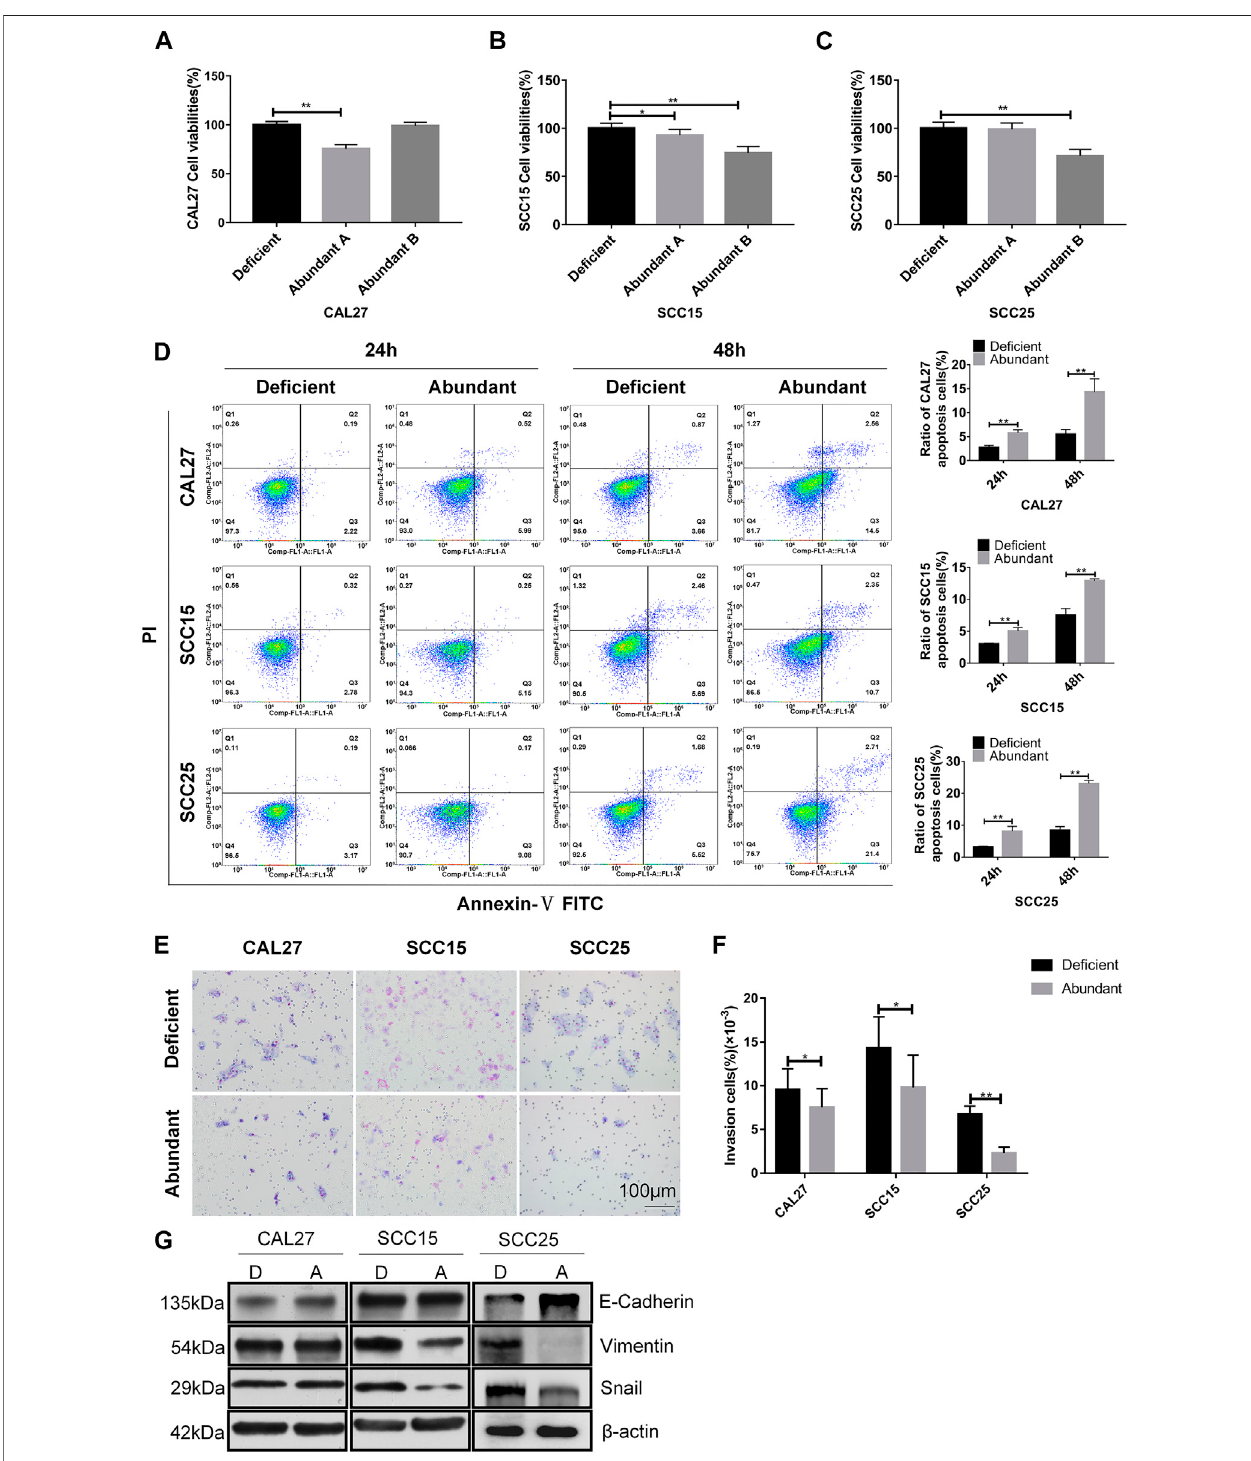
FIGURE2 | Effectsofanti-HER2IgG-abundantplasmaontheproliferationofOSCCcells. (A – C) ProliferationofthreeOSCCcelllinestreatedwithanti-HER2IgG-abundant plasmafor48 h.PlasmaAandplasmaBobtainedfromtwoindividualhealthydonorswereabundantinanti-HER2IgG.Thedataofproliferationwereexpressedasmean ± SDin cellviability(%).PlasmaAshowedaninhibitoryeffectonCAL27andplasmaBonbothSCC15andSCC25cells. (D) ApoptosisofthreeOSCCcelllinestreatedwithanti-HER2IgG- abundantand-de fi cientplasmafor24and48 h,respectively.Thedatawereexpressedasmean ± SDinproportionofapoptoticcells. (E – F) ThreeOSCCcelllinestreated witheither20%anti-HER2IgG-abundantor-de fi cientplasmafor48 hwerephotographedandbarchartshowedtheproportionofinvasivecellsrelativetototalnumberofseeding cells. (G) ThreeOSCCcelllineswereculturedin20%anti-HER2IgG-abundantor-de fi cientplasmaandtheexpressionofEMT-relatedfactors,E-cadherin,Vimentin,orSnailwas then determined by Western blot with β -actin as reference. D: anti-HER2 IgG-de fi cient plasma; A: anti-HER2 IgG-abundant plasma; * p < 0.05; ** p < 0.01.